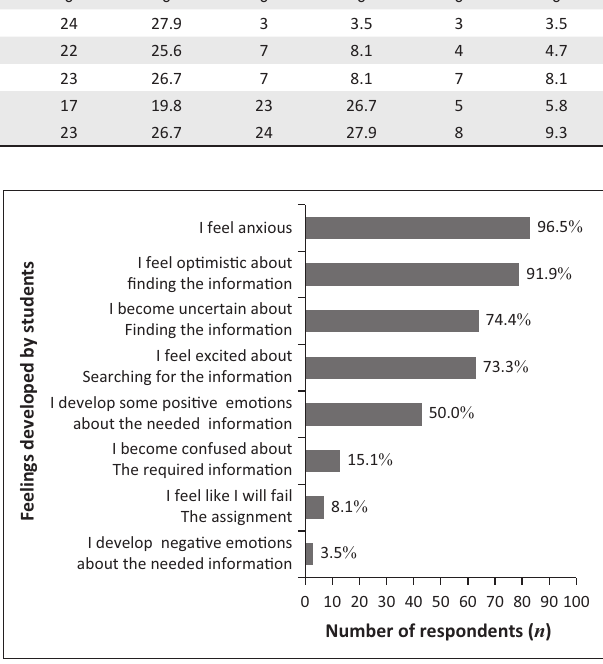
FIGURE 3: Feelings of students during information search ( n = 86).